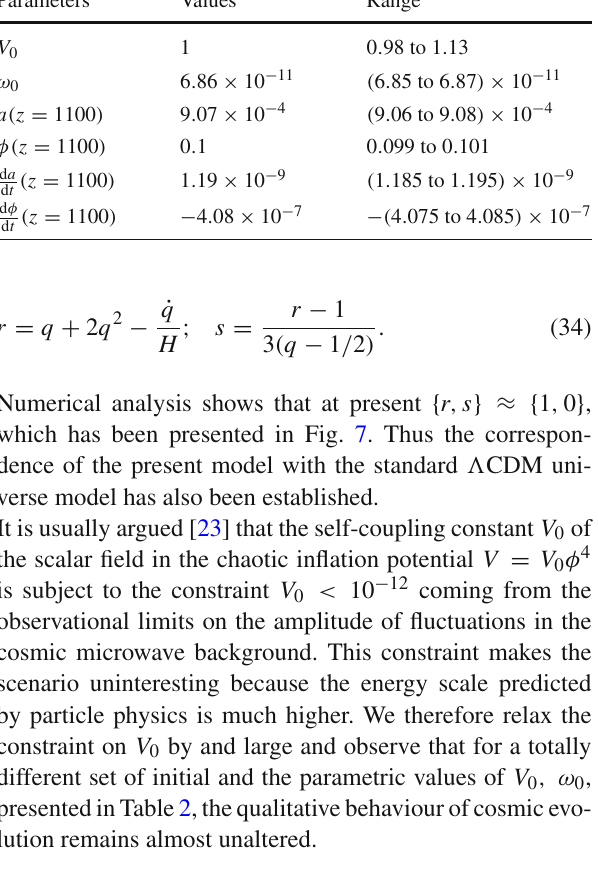
Fig. 7 The state-finder s versus r plot represents perfect correspon- dence of the present model with the standard (cid:12) CDM model Table 2 A second range of parametric values to which late-time cos- mological data fits as well